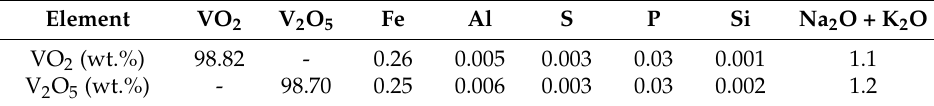
Table 3. Chemical composition of VO 2 and V 2 O 5